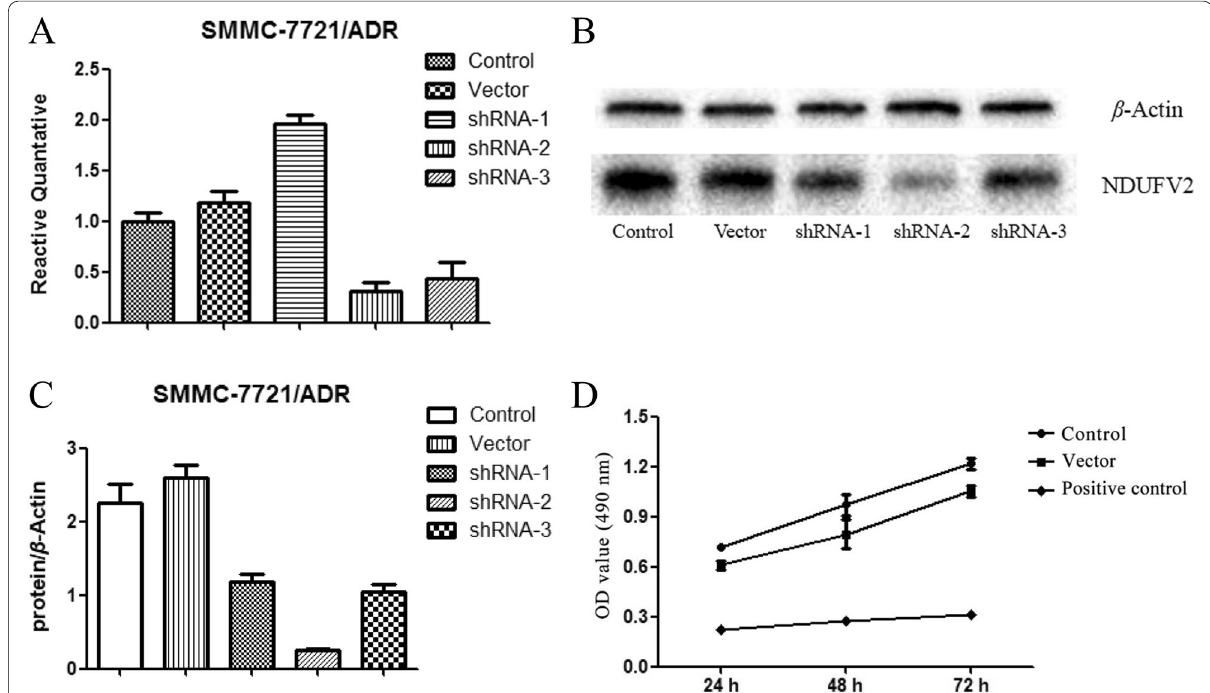
Fig. 1 Inhibition of NDUFV2 gene silencing on the proliferation of SMMC-7721/ADR cells. A The relative quantitative of NDUFV2 mRNAs in each group of SMMC-7721/ADR. The expression level of the NDUFV2 gene in each group was detected 24 h after transfection. B The protein expressions of NDUFV2 after transfection in SMMC-7721/ADR. β-actin was used as an internal reference protein and NDUFV2 was used as the target protein. C The protein expressions of NDUFV2 after transfection in SMMC-7721/ADR. β-actin was used as an internal reference protein and NDUFV2 was used as the target protein. For A , B , and C , cells transfected with PPLK /GFP PURO-NDUFV2 shRNA-1, 2, and 3 were used as the positive control + (shRNA-1, 2, 3), and cells transfected with empty plasmid were used as negative control (vector), and the blank control group did not do any treatment (control). D The growth curves of each group of SMMC-7721/ADR after transfection at different time points x ± s , n =